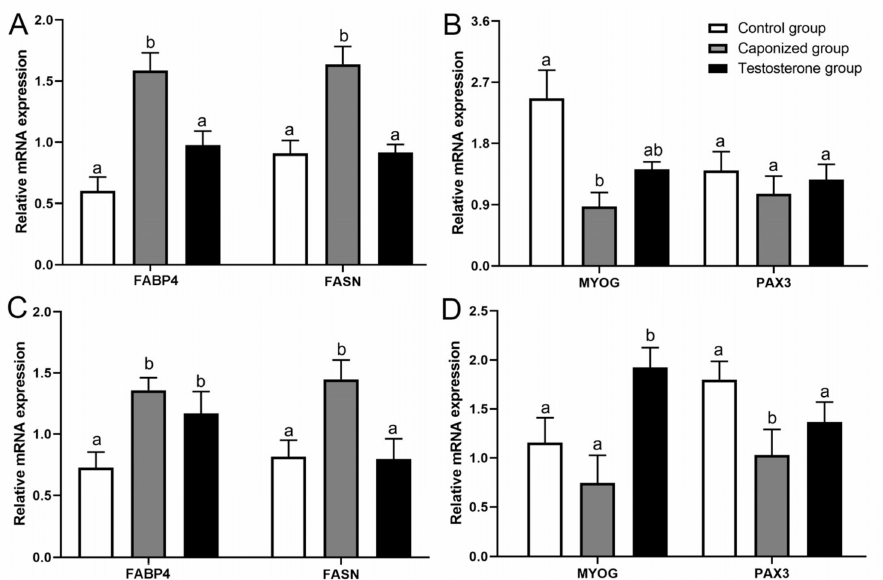
Figure 6. Genes’ mRNA levels relative to β -actin , FASN , FABP4 , MYOG , and PAX3 of the leg muscle tissues ( A , B ) and breast muscle tissues ( C , D ) in the control, the caponized group, and the testosterone group. Data are shown as mean values ± standard error of the mean. Vertical bars represent the standard errors of the mean. Different letters above the bars denote significant differences ( p <